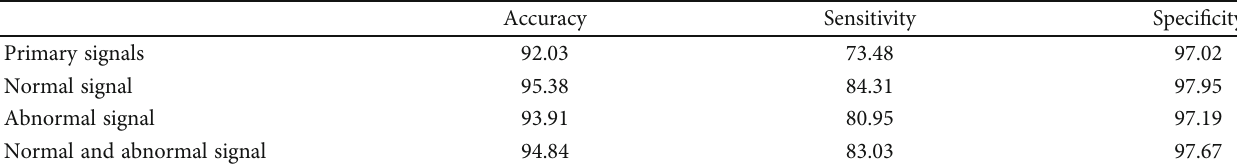
Table 6: Test performance comparison